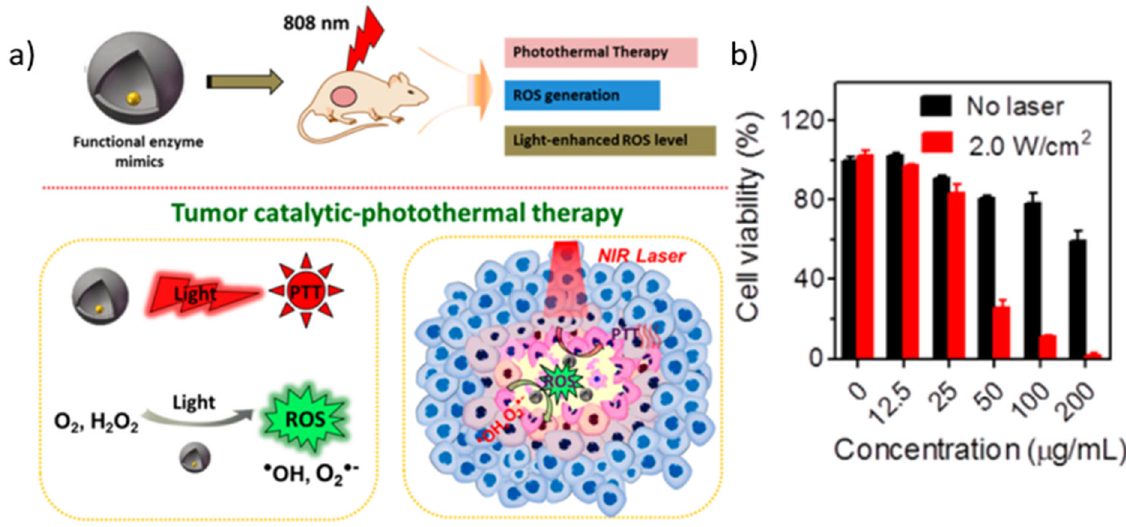
Figure 2. ( a ) Scheme of the action of Au@HCNs under 808 nm radiation. ( b ) Relative viabilities of CT26 cell incubated with Au@HCNs under 808 nm laser irradiation for 10 min. Reprinted with permission from [29]. Copyright © 2018 American Chemical Society. permission from [29]. Copyright © 2018 American Chemical